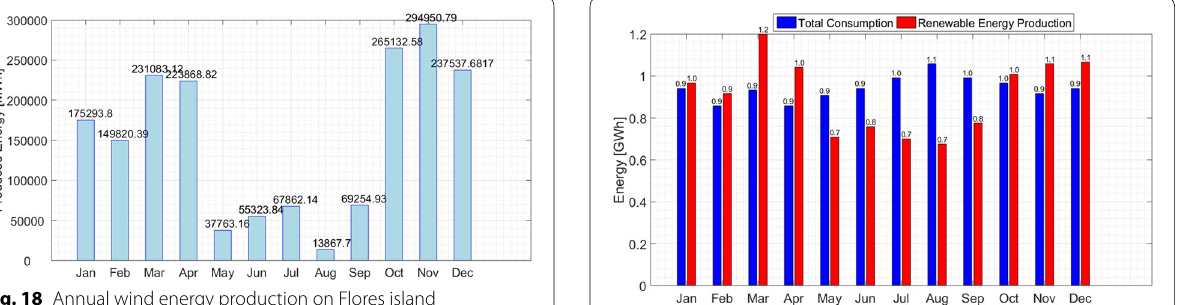
Table 22 Summary of data evaluating the investment made on each island for the second solution Island